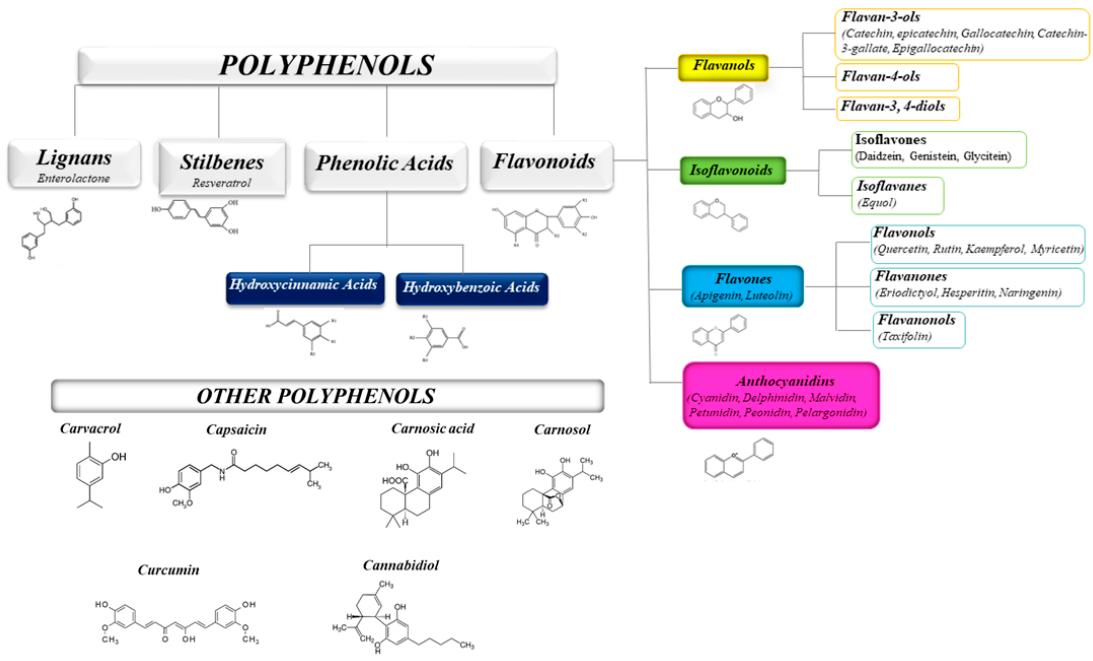
Figure 1. Schematic classification of the polyphenol family and flavonoid groups putatively exploited as antiviral phytochemical.